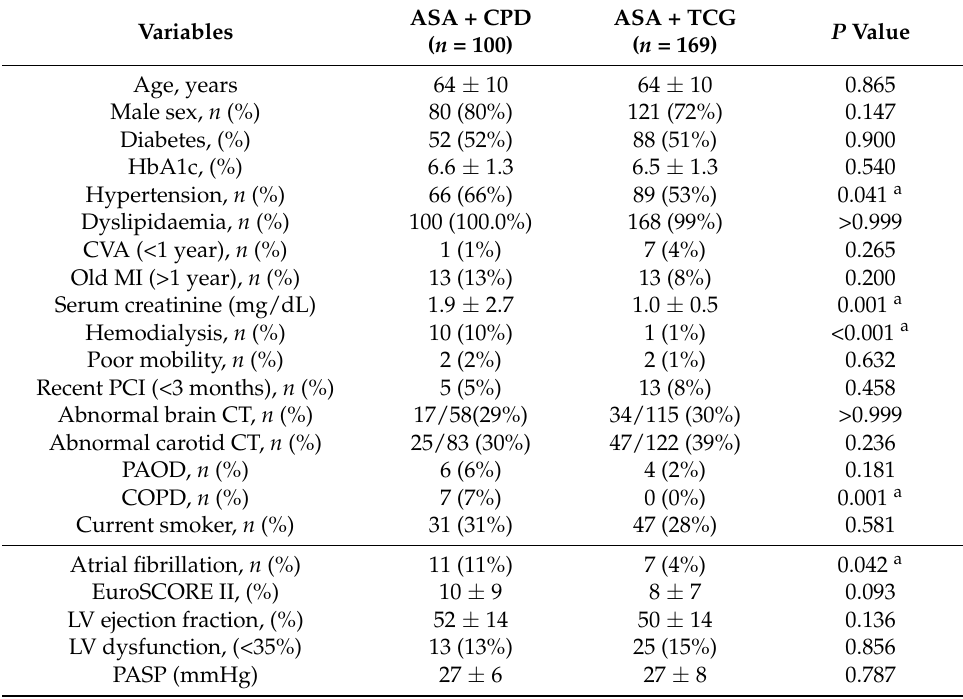
Table 1. Baseline characteristics of the